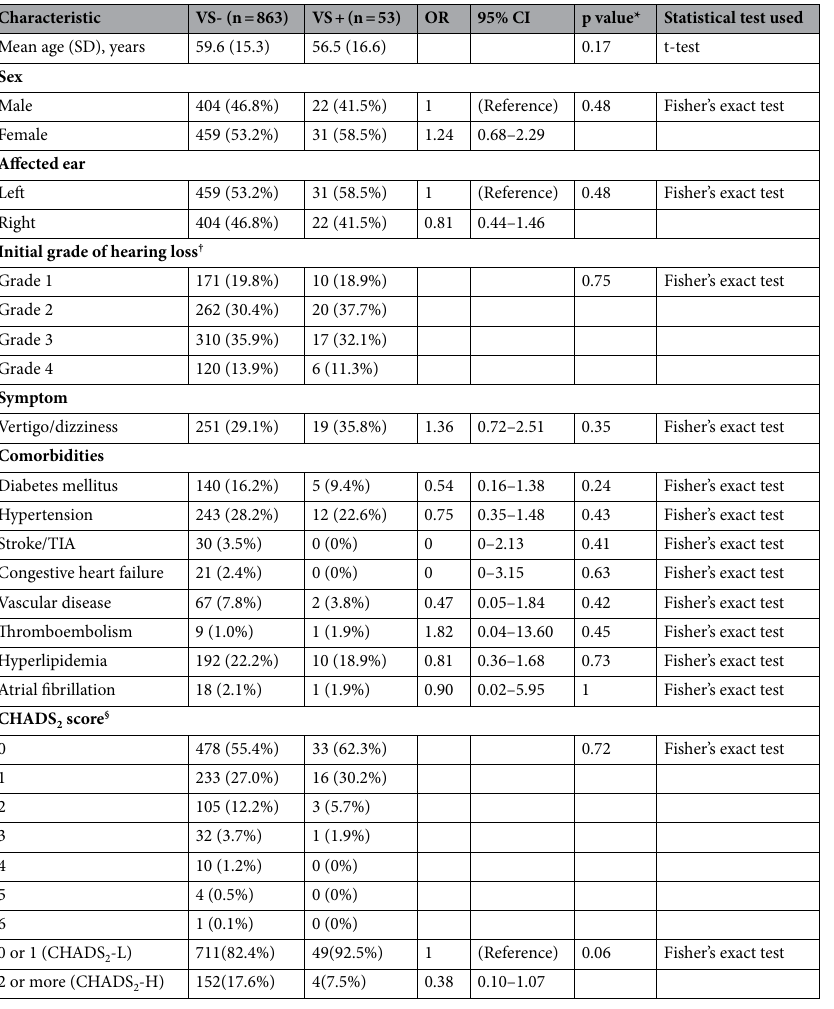
Table 2. Demographic and clinical characteristics of included SSNHL patients with and without vestibular schwannoma. SD standard deviation, TIA transient ischemic attack, VS vestibular schwannoma, VS + confirmed vestibular schwannoma by MRI, VS − no evidence of vestibular schwannoma, OR odd ratio, 95% CI 95% confidence interval, CHADS 2 -L low-scoring CHADS 2 , CHADS 2 -H high-scoring CHADS 2